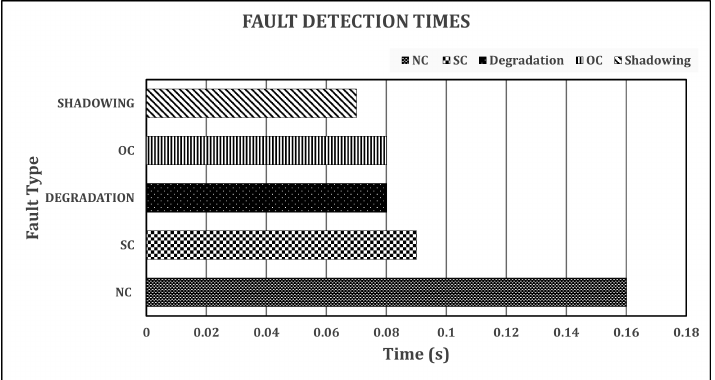
Figure 9. Fault detection